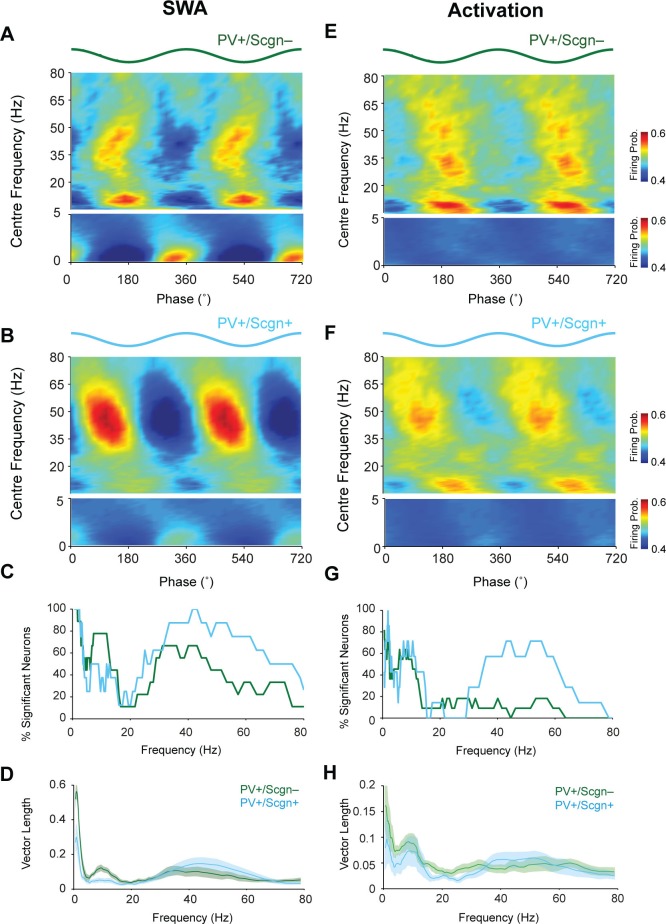
The firing of PV+/Scgn- and PV+/Scgn+ striatal interneurons is distinctly phase locked to cortical oscillations in the rat.(A,B) Mean phase histograms of the firing of striatal PV+/Scgn- (A) and PV+/Scgn+ (B) interneurons with respect to cortical oscillations of 0.4–80 Hz during SWA. Note the stronger locking of the firing of PV+/Scgn- interneurons to slow (0.4–1.6 Hz) and spindle (7–12 Hz) frequencies, and the stronger locking of PV+/Scgn+ interneurons to gamma oscillations (30–80 Hz) (C) Histogram showing the proportions of PV+/Scgn- (green) and PV+/Scgn+ (blue) interneurons that exhibited significantly phase-locked firing (as measured by the Raleigh test, with p<0.05) in each frequency range of cortical oscillation during SWA. (D) Mean vector lengths calculated across all PV+/Scgn- (green) and PV+/Scgn+ (blue) neurons recorded during SWA (PV+/Scgn+ n = 9; PV+/Scgn- n = 8) from 0 to 80 Hz. Shaded areas show SEMs across neurons. (E,F) Mean phase histograms of striatal PV+/Scgn- (E) and PV+/Scgn+ (F) interneurons for cortical oscillations of 0.4–80 Hz during cortical activation. (G) Histogram showing the proportions of PV+/Scgn- (green) and PV+/Scgn+ (blue) neurons that were significantly locked in each frequency range of cortical oscillation during cortical activation. (H) Mean vector lengths calculated across all PV+/Scgn- (green) and PV+/Scgn+ (blue) neurons recorded during cortical activation (PV+/Scgn+ n = 11; PV+/Scgn- n = 7). Shaded areas show SEMs across neurons. (A, B, E, F, frequencies between 0–5 Hz are separated to allow for a wider color scale)DOI:
http://dx.doi.org/10.7554/eLife.16088.01210.7554/eLife.16088.013Figure 6—source data 1.Source data for Figures 6C,D,G,H.